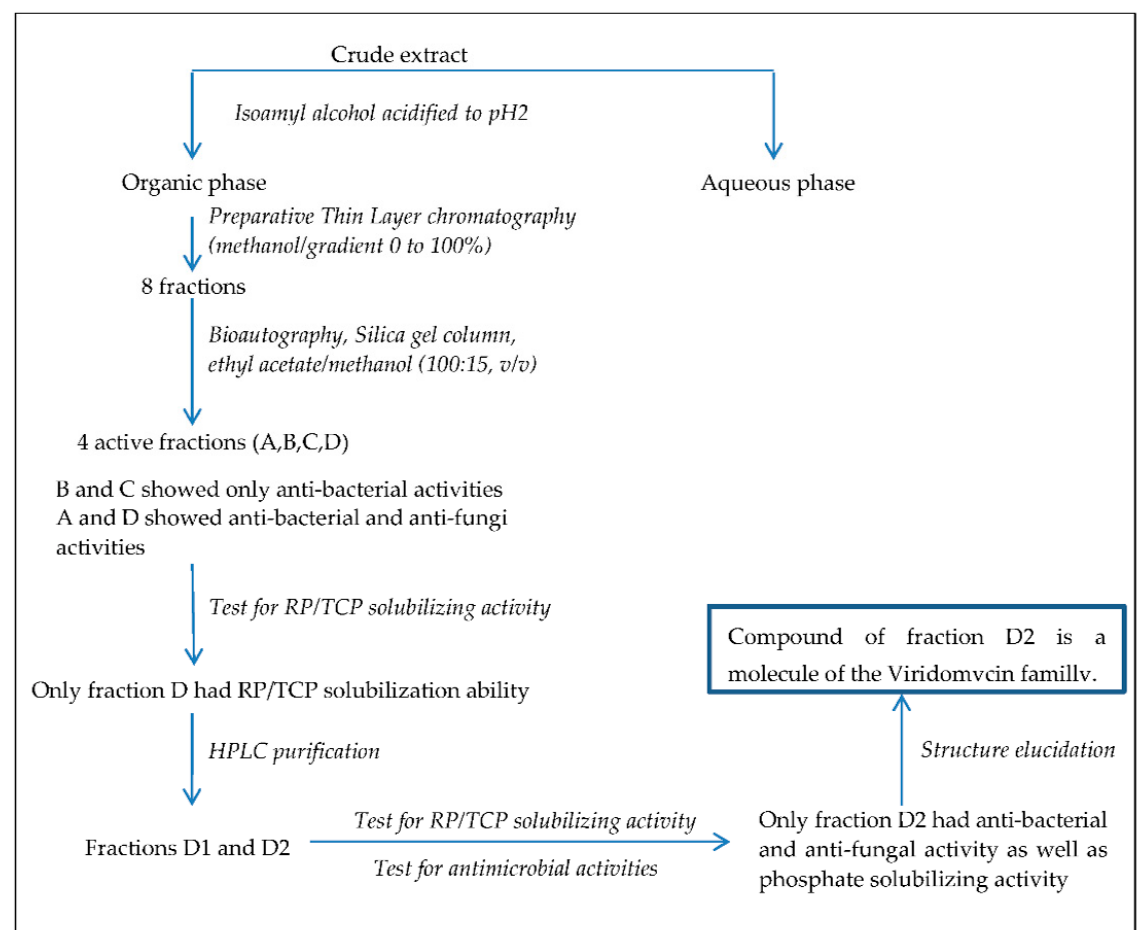
Figure 1. Schematic representation of the workflow used to purify the molecule of the viridomycin family possessing both phosphate-solubilizing and antimicrobial activity. RP and TCP stand for Rock Phosphate and Tri Calcium Phosphate, respectively. HPLC stands for High Performance Liquid Chromatography.